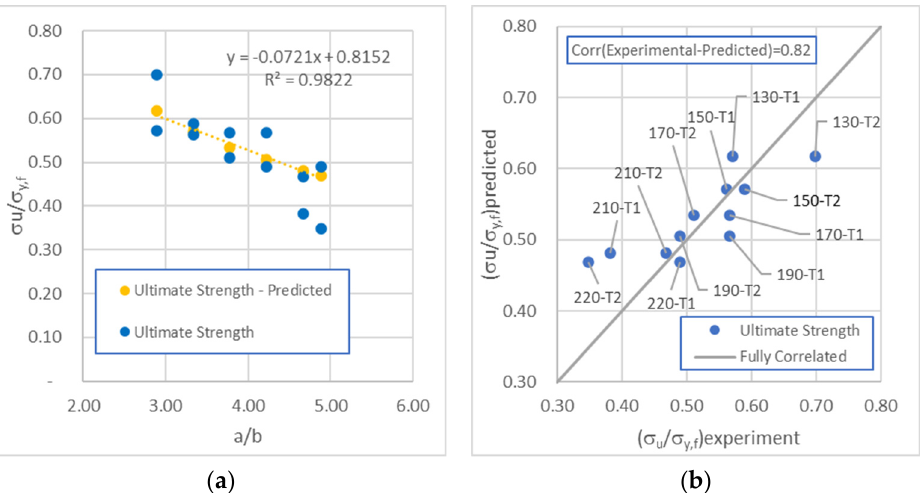
Figure 10. Normalised ultimate strength as a function of a/b ( a ) and correlation between experimental and predicted ultimate normalised strength ( b ).